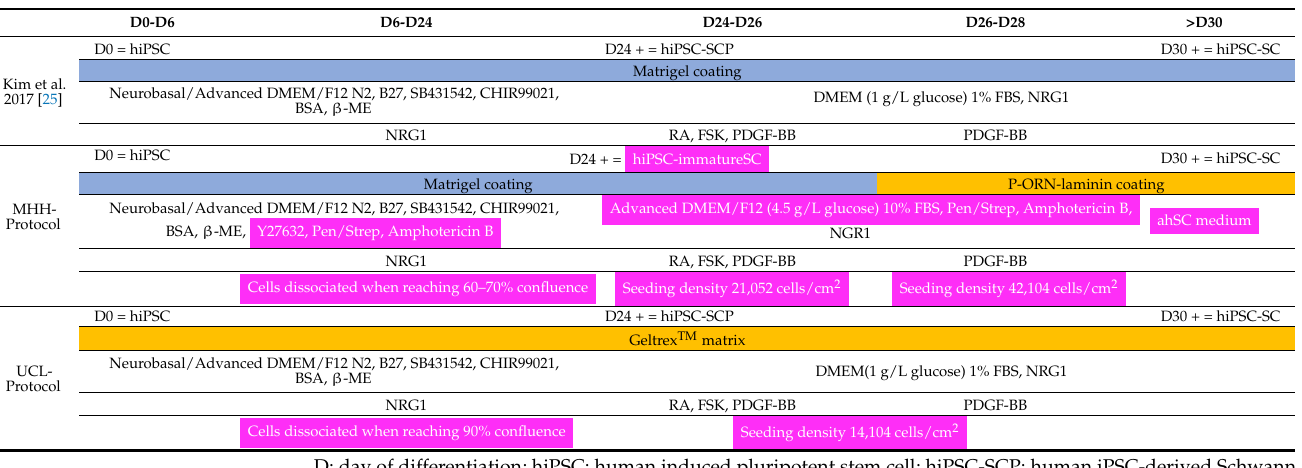
Table 1. Comparison of three differentiation